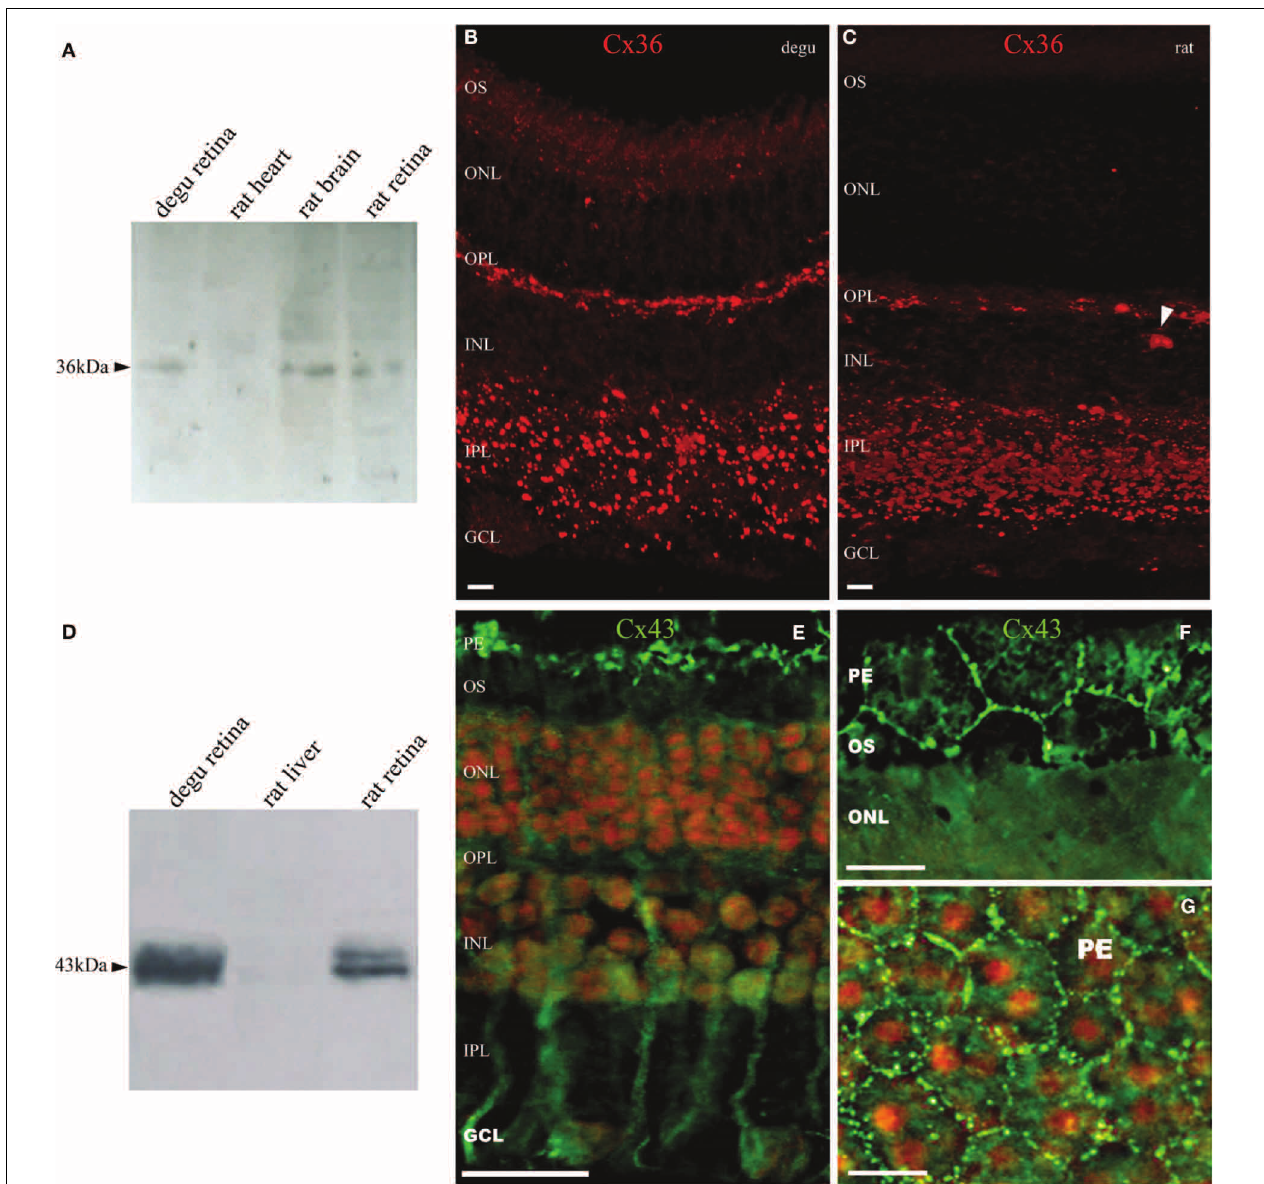
FIGURE 2 | Expression and immunolocalization of Cx36 and Cx43 in the retina of degu. (A) Immunodetection of Cx36 (arrowhead) in retinal extracts of degu and rat, and brain cortex as positive control. No immunostaining was visible in heart extracts of rat. (B,C) Fluorescent micrograph showing Cx35/36 immunolabeling in degu and rat retina. Immunolocalization of Cx36 along the OPL and in the IPL was observed as intensely fluorescent puncta. Less frequently, Cx36 labeling was observed in the GCL, where puncta were localized to the margins of cell bodies. The arrowhead points to a blood vessel with strong non-specific labeling ( D) Immunodetection of Cx43 in retinal extracts of degu and rat. Cx43 shows the expected electrophoretic